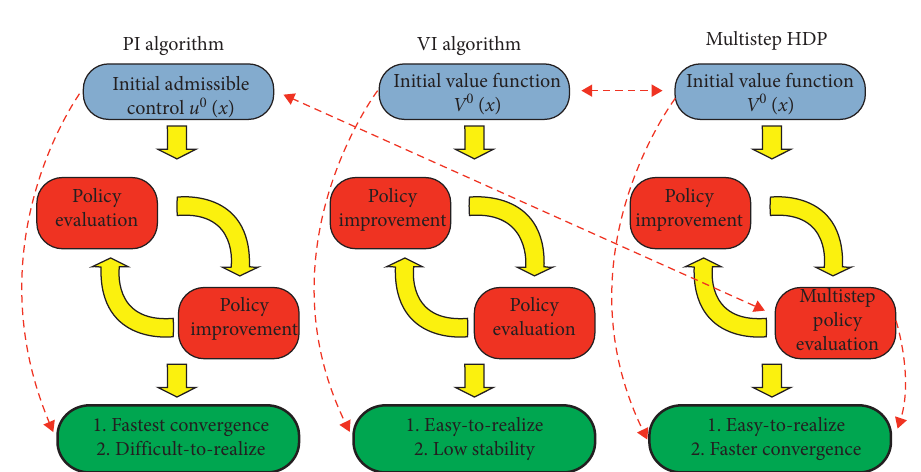
Figure 3: Relationship and difference among PI algorithm, VI algorithm, and multistep HDP.